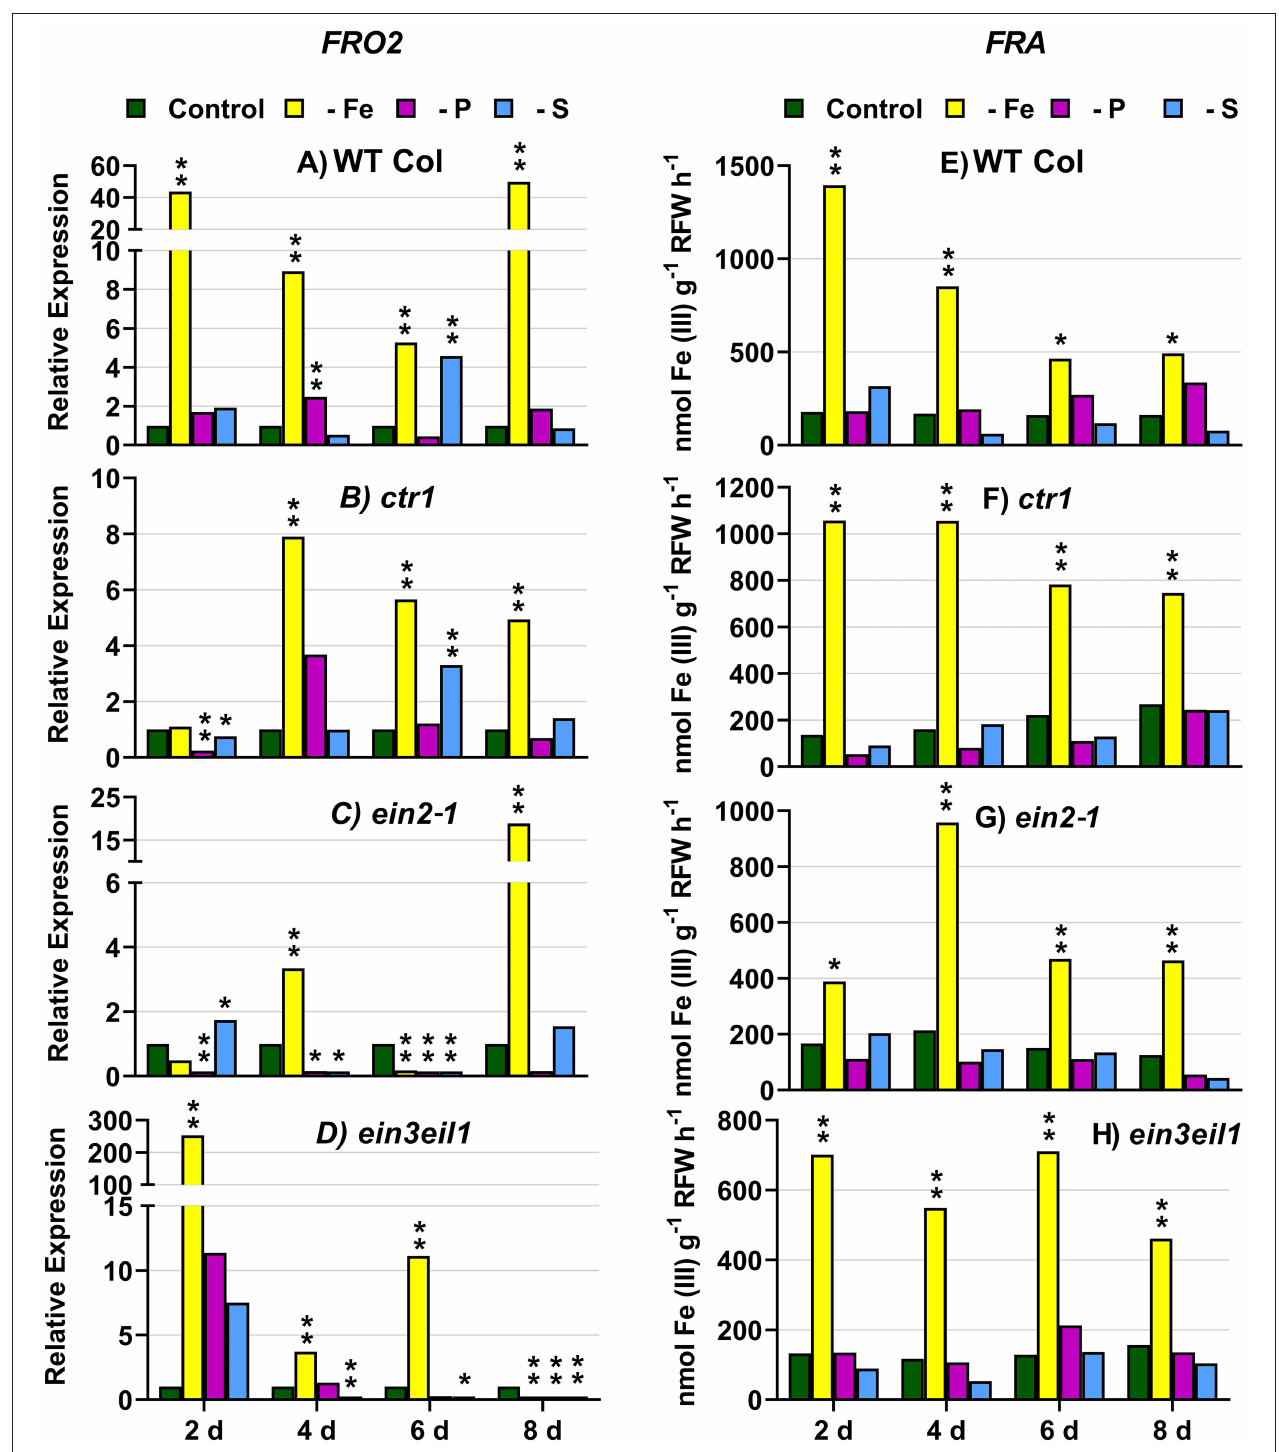
FIGURE 1 | Effect of Fe, P, or S deficiency on the expression of the Fe-related gene FRO2 (left: A – D ) and of ferric reductase activity (FRA; right: E – H ) in roots of the Arabidopsis WT Columbia and its ethylene mutants ctr1 , ein2-1 , and ein3eil1 . Plants were grown in complete nutrient solution. When appropriate, some of them were transferred to complete nutrient solution (control), nutrient solution without Fe (–Fe), without P (–P), or without S (–S). After 2, 4, 6, and 8 days of the treatments, FRA and FRO2 expression were determined. Relative expression was calculated in relation to the control of each genotype and day. Data of FRO2 expression represent the mean of three independent biological replicates. Data of FRA represent the mean of six replicates. Within each day and genotype, * P < 0.05 or ** P < 0.01 are significant differences in relation to the control treatment.